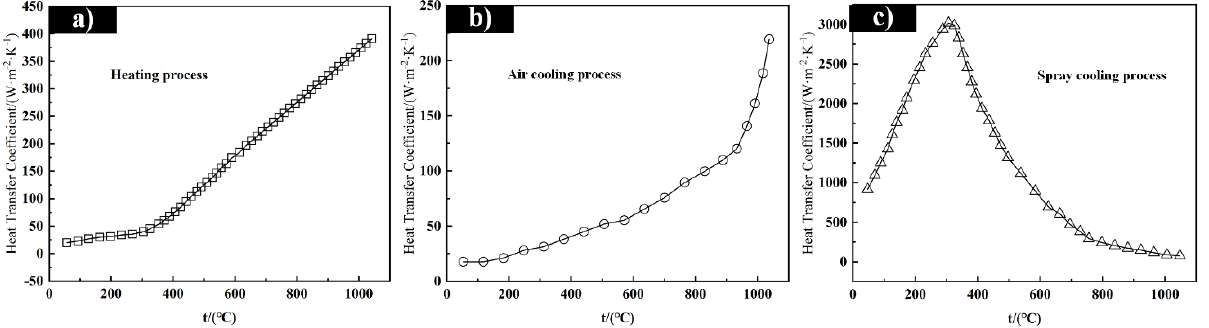
Figure 1. Heat transfer coefficient of Cr5 steel in different processes. ( a ) Heat transfer coefficient in